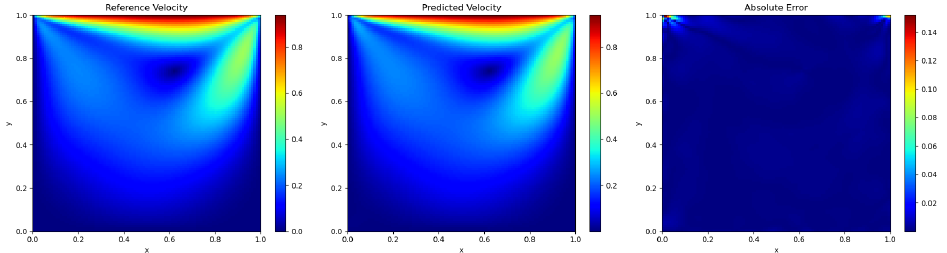
Figure 20. Results of Equation (70). Reference velocity ( left ); predicted velocity ( middle ); absolute error ( right ).